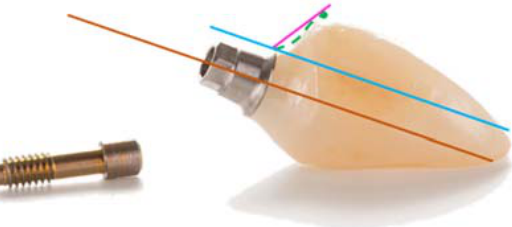
Figure 4. Emergence angle (EA) definition. Brown line: parallel to implant long axis. Blue line: parallel to the brown line and the line tangential to the implant shoulder. Pink line: from implant to abutment connection point to the emergence profile. The angle of the intersection between pink and blue lines resulted in the emergence angle (EA). Green line: buccal emergence profile (EP) shape. A concave area provides a support to the junctional epithelium, while the convex area supports the sulcular